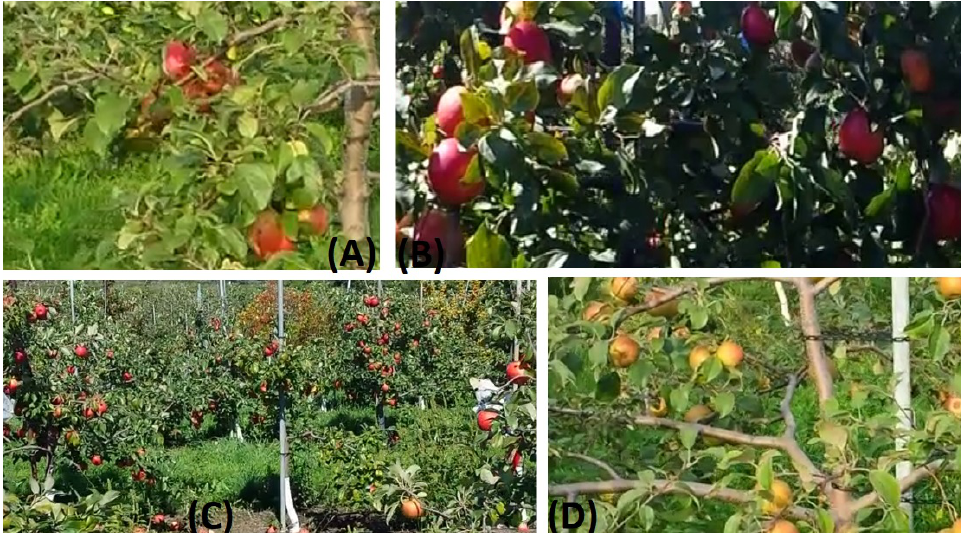
Figure 2. Some challenges encountered by an image-based automated apple recognition system: ( A ) occlusion, ( B ) various surrounding illumination levels, ( C ) variable distance of apple trees, and ( D ) multiple colors of apple